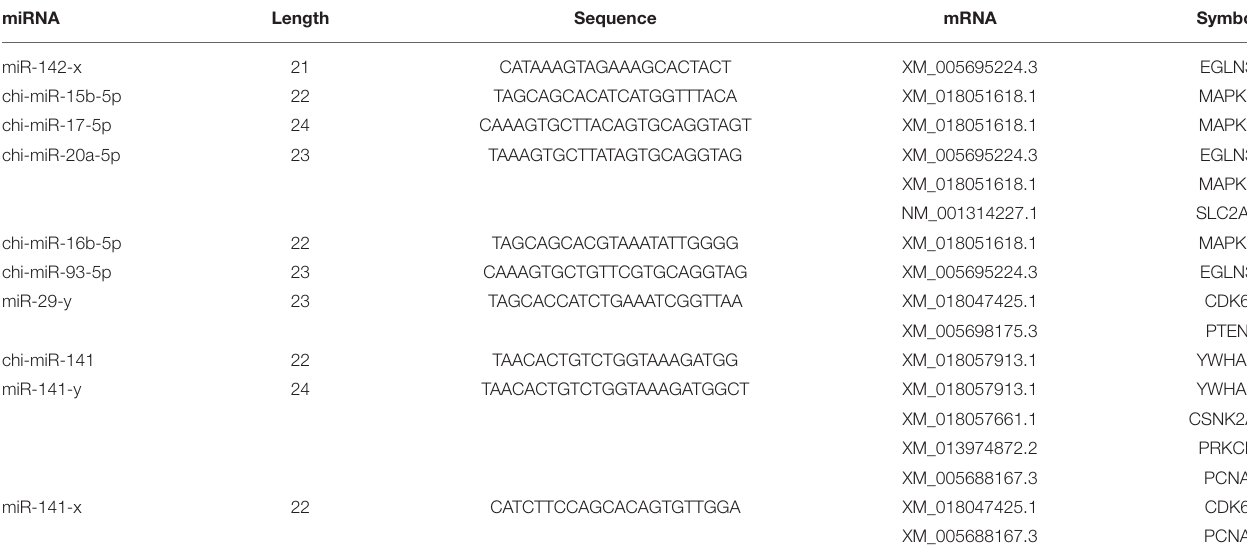
TABLE 6 | Sequences of core miRNAs and their target